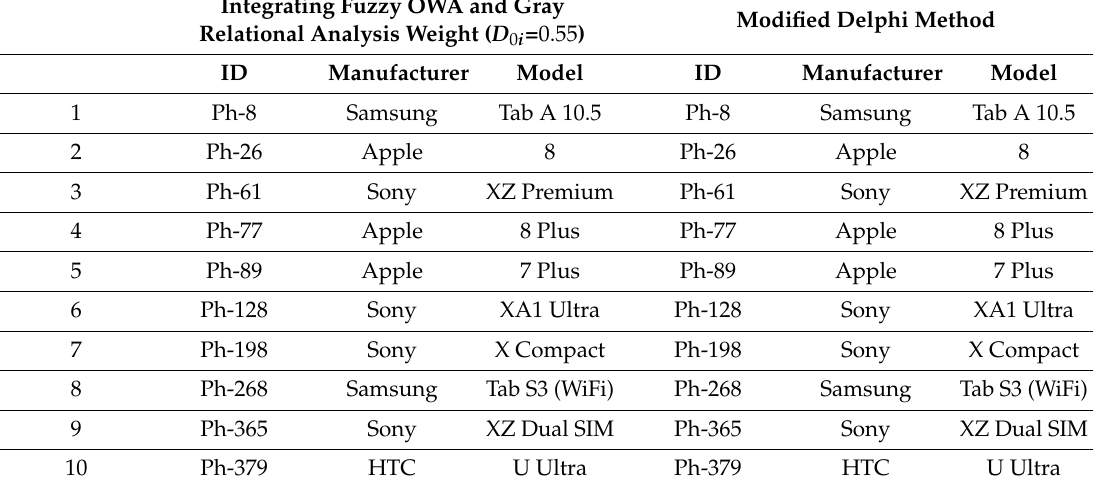
Table 4. Mobile phone product data recommended by the first experimental